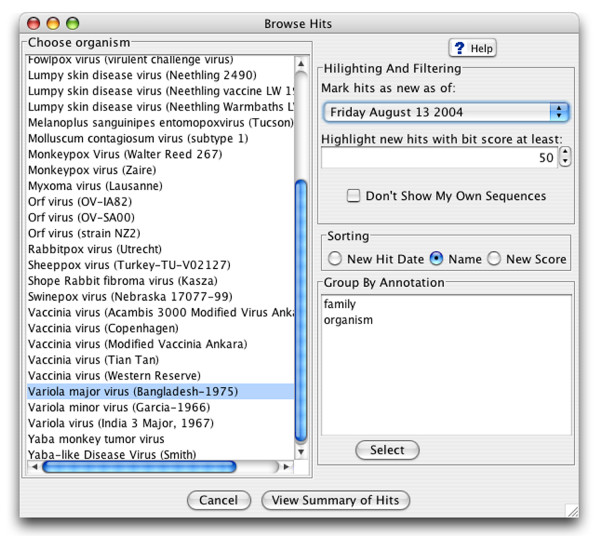
Hits browser window. The ReHAB database is searched by selecting an organism name, then choosing the desired highlighting and filtering options. Clicking on "Show Summary" opens a new window to display the results.